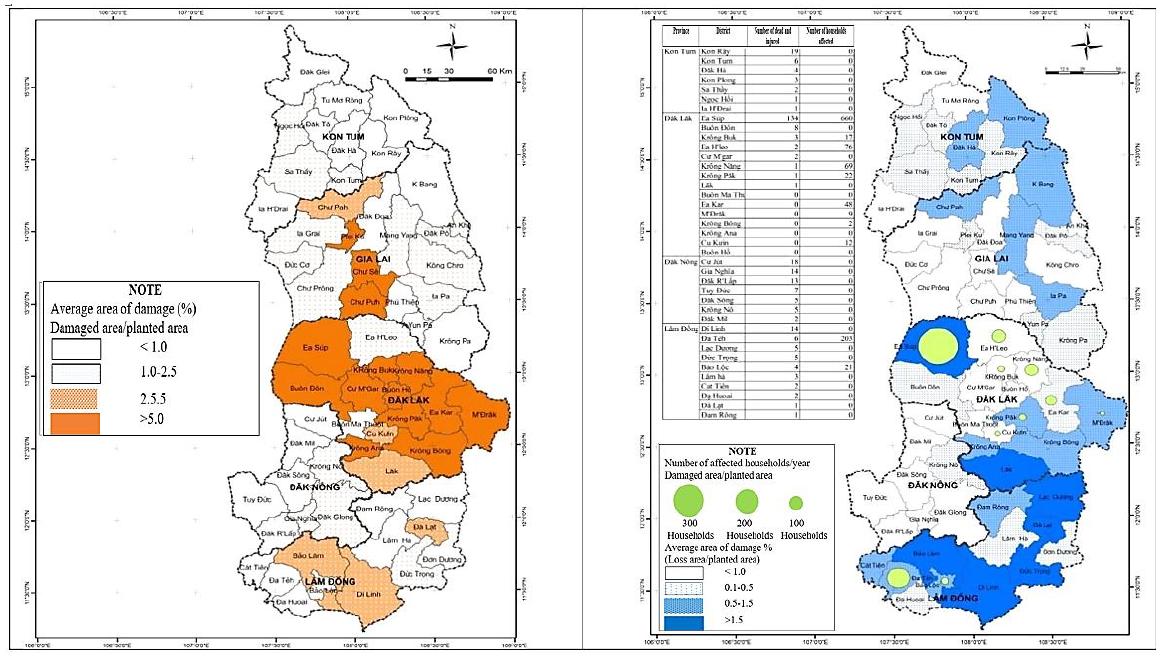
Figure 2. Disaster map of the Central Highlands provinces from 2015-2020